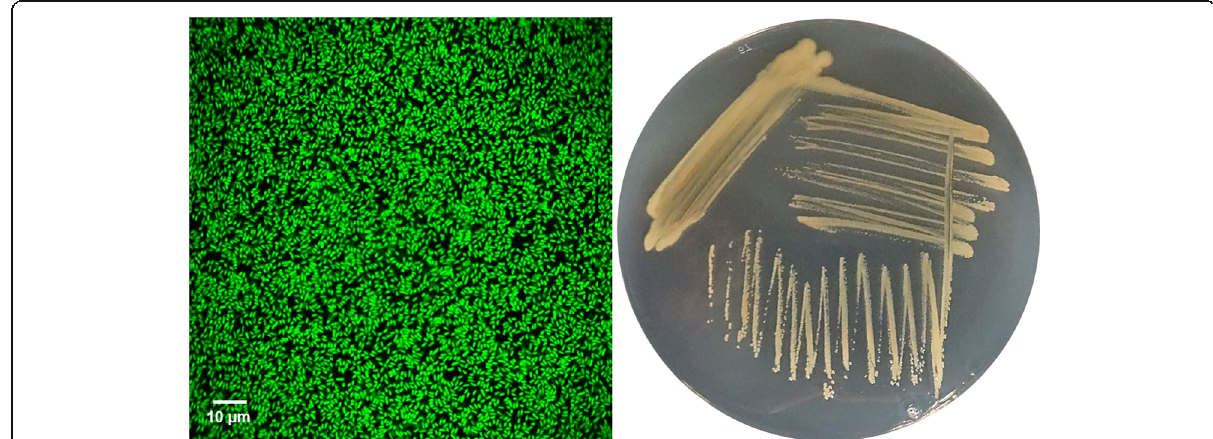
Fig. 1 Photomicrographs of source organism. Image of P. corrugata RM1-1-4 cells using confocal laser scanning microscopy (CLSM, left) and the appearance of colony morphology after 48 h growing on NB agar medium at 25 °C (right). Image was obtained using acridin orange (0.4 mg mL − 1 water) stained RM1-1-4 cells with 40× magnification. Cells under Leica TCS SP CLSM (Leica Microsystems, Wetzlar, Germany) captured and analysed using Leica Application Suite Advanced Fluorescence (LAS AF) software Version